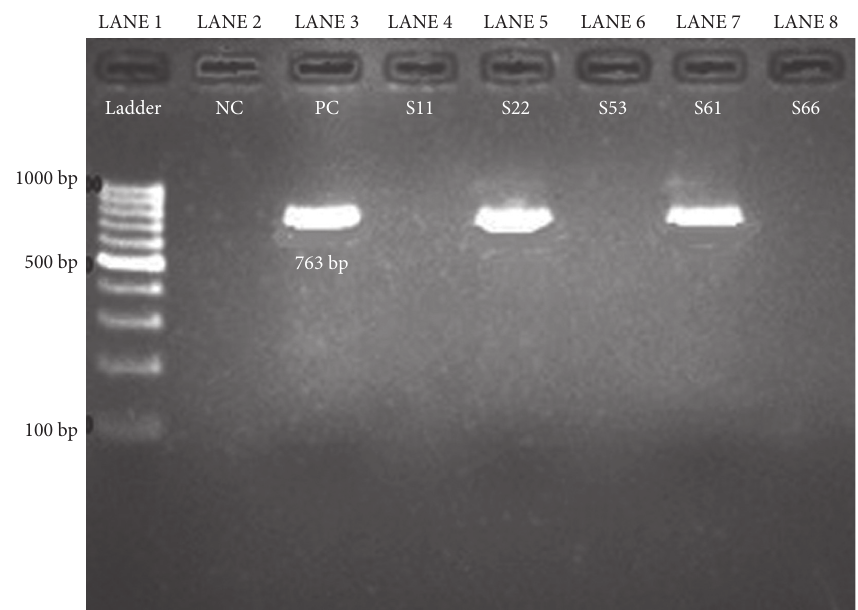
Figure 2: Amplification of the vanA gene from S. aureus isolates by conventional PCR (L1, DNA ladder 100–1000bp; L2-NC, negative control; L3-PC, positive control; L4 to L8, S. aureus isolates; and S22 and S61 isolates were positive for the vanA